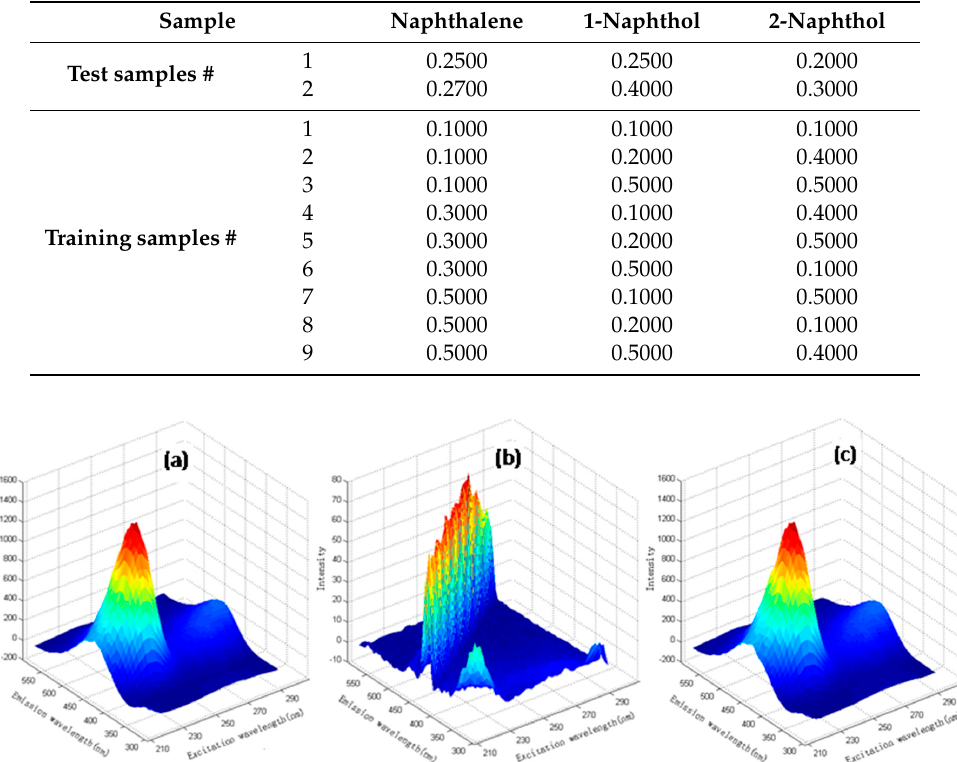
Table 2. Concentrations of components in samples (mg / L).